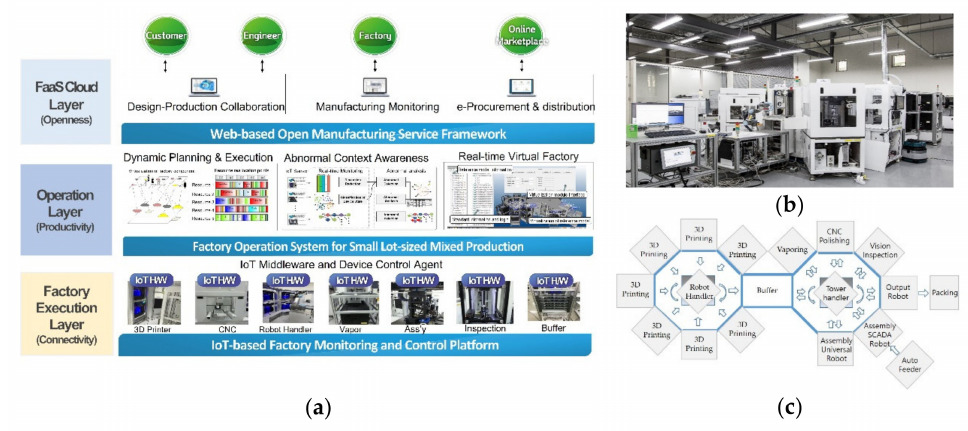
Figure 1. FaaS platform configuration: ( a ) FaaS platform architecture; ( b ) real manufacturing line; ( c ) octagonal modular factory.